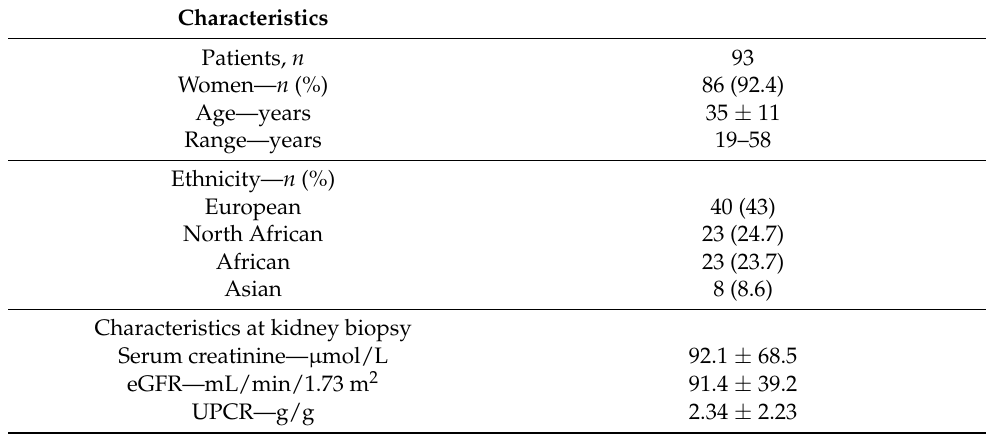
Table 1. Patients’ baseline